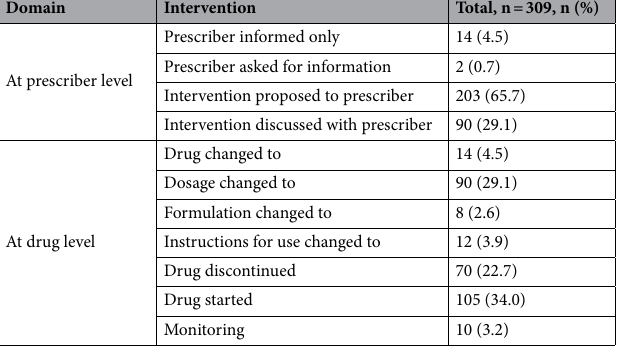
Table 4. Interventions to resolve the DRPs provided by clinical